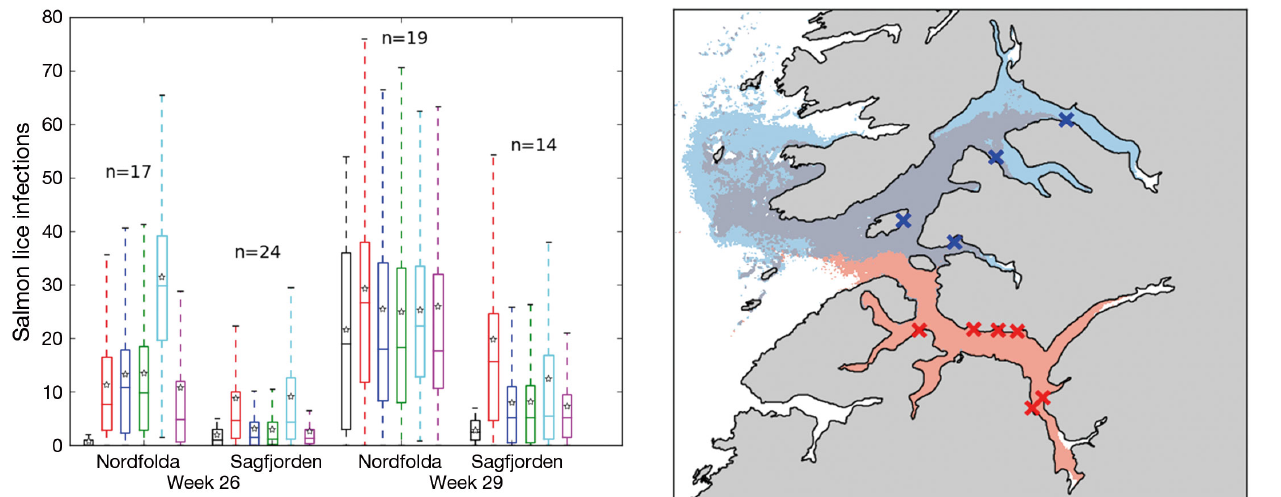
Fig. 9. Observed (black box) and simulated (coloured boxes, colour codes as in Fig. 8) salmon lice Lepeophtheirus sal - monis infections on wild sea trout Salmo trutta (n = no. of fish). Note that the boxes show the 25 th and 75 th percentiles for the variation in infestation for the observations, and variation be- tweenthehorizontalgridsforthemodel;whiskers showextremes